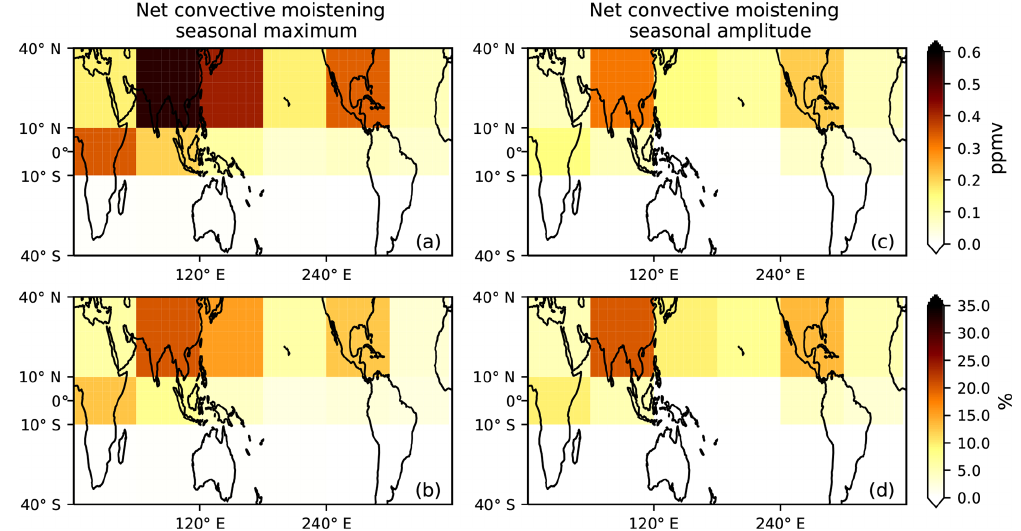
Figure 9. Portions of net convective moistening (ppmv) in the (a) maximum value and (b) seasonal amplitude of the 100hPa 10–40 ◦ N water vapor seasonal cycle contributed by 12 equal-area box regions between 10 ◦ S and 40 ◦ N. (c–d) Same as (a) and (b) but for the percentage of net convective moistening contributed by the 12 equal-area box